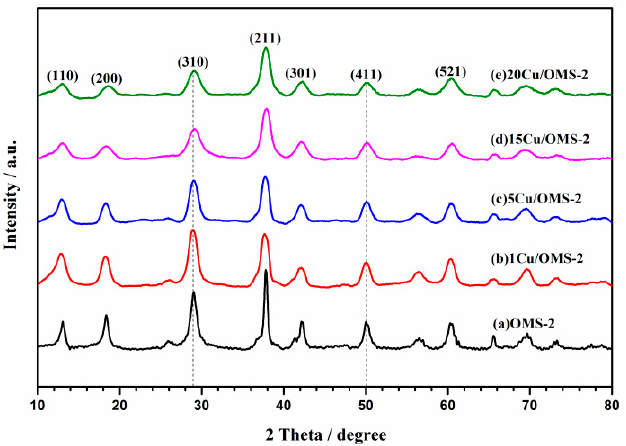
Figure 1. XRD patterns of ( a ) OMS-2, ( b ) 1Cu/OMS-2, ( c ) 5Cu/OMS-2, ( d ) 15Cu/OMS-2, and ( e ) 20Cu/OMS-2.